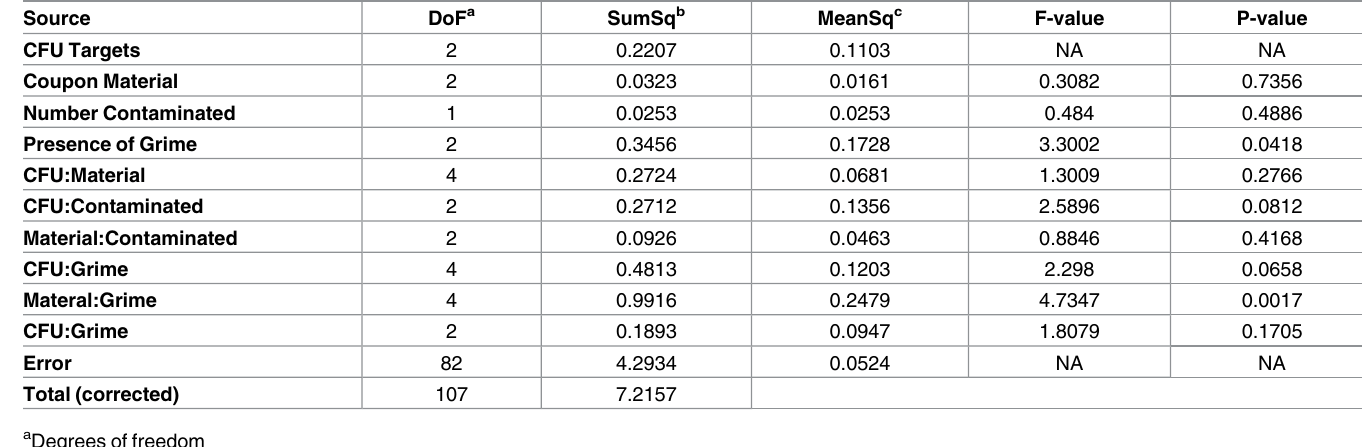
Table 4. ANOVA results show that the presenceof grime and the interaction between coupon type and grime presence are significant for RE.